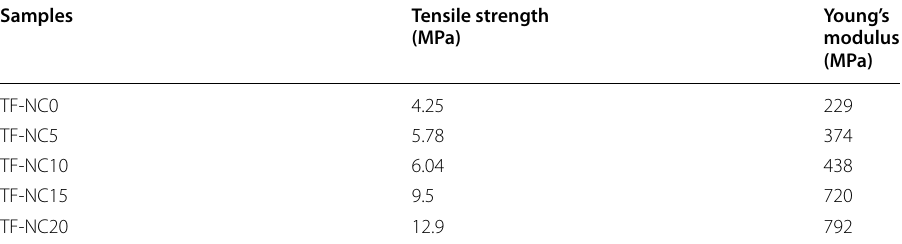
Table 5 Tensile strength and Young’s modulus for the various nanochitosan compositions of polymer electrolytes (PMMA-LiTf-nanochitosan)